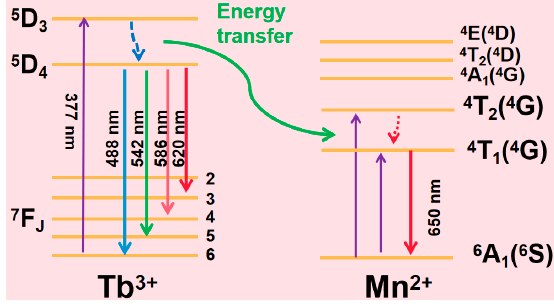
Figure 5. Energy-transfer mechanism for Tb 3+ to Mn 2+ in the CTP matrix.